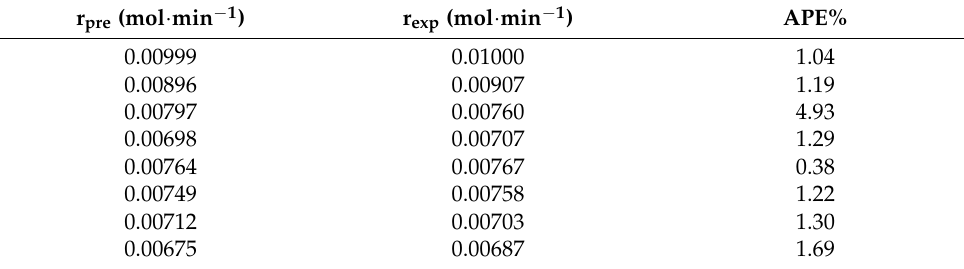
Table 5. Experimental and predicted initial gas consumption rate of CH 4